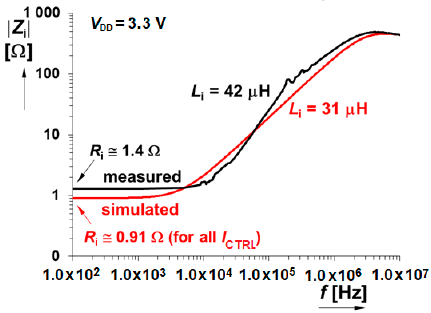
Figure 15. Input impedance frequency response.